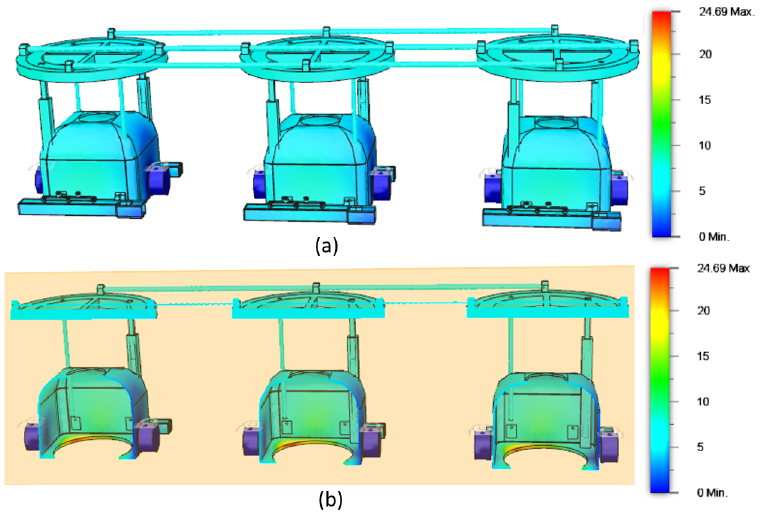
Figure 9. Deformation (mm) of the Mantis-mini platform ( a ) full view and ( b ) sectional view.